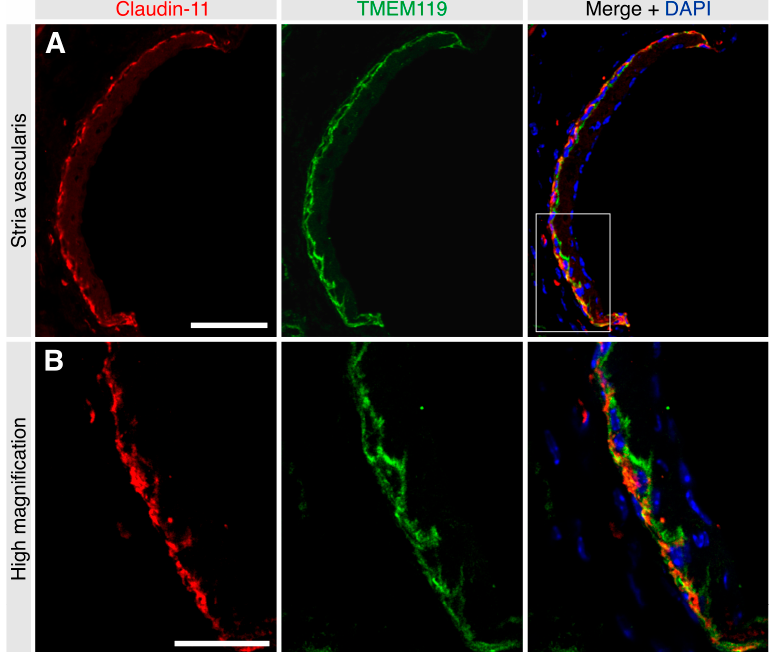
Figure 4. Frozen sections of the adult mouse stria vascularis labeled for TMEM119 (green) and claudin-11 (red). Nuclei were counterstained with DAPI (blue). ( A ) TMEM119 protein expression was detected in the basal cells of the stria vascularis colocalizing with the gap junction protein claudin-11. Scale bar: 50 µm. ( B ): The inset represents the high magni fi cation image, which shows the colocalization between the TMEM119 cytoplasmic signal (green) and the claudin-11 signal (red) that appears concentrated in the basolateral aspect of the strial basal cells. Scale bar: 20 µm. Noise trauma appeared to have no visible e ff ect on the TMEM119 localization pa tt ern in the stria vascularis, which remained localized to the basal cells, showing an indistin- guishable pa tt ern in the noise-exposed and sham-exposed groups (Figure 5a,b) ( n = 5 each). Similarly, noise exposure appeared to cause no gross change in the expression of TMEM119 in the supralimbal zone (Figure 6a,b, n = 5 each).